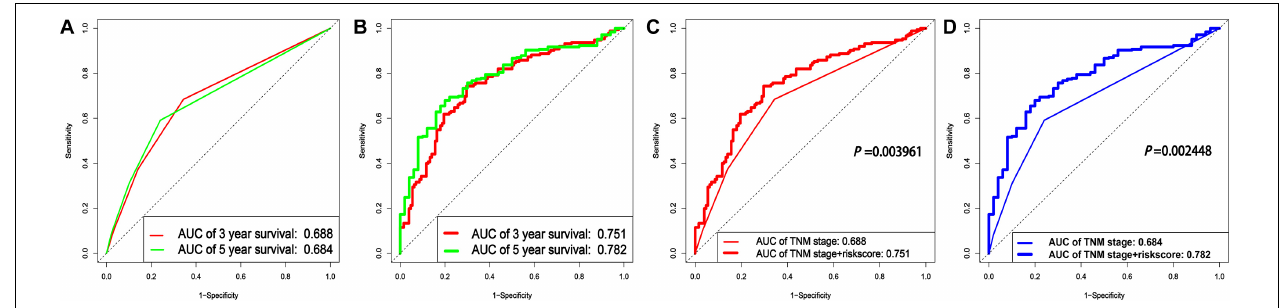
FIGURE 5 | A comparison between the clinical genomic model with both the TNM stages and the lncRNA signature and with the clinical model with the TNM stages only. (A) The ROCs of two periods of survival for the conventional model with the TNM stages only. (B) The ROCs of two periods of survival for the clinical genomic model with both the TNM stages and the lncRNA-based signature included. (C,D) Comparison of the two models for prognosis prediction over the two periods (3 and 5 years),